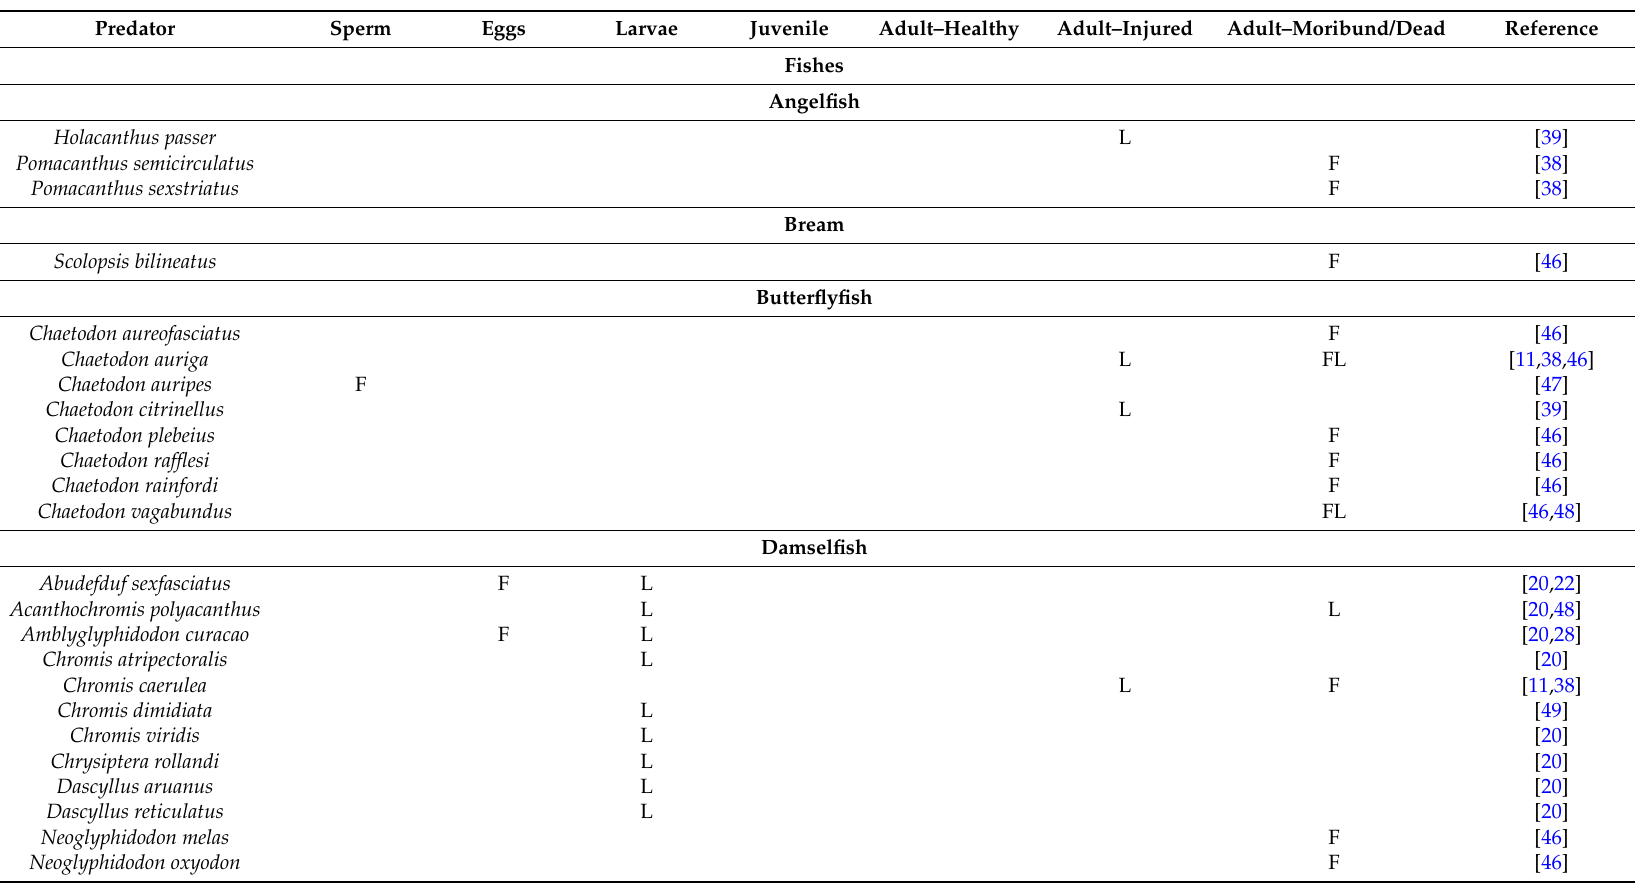
Table 1. Species that feed on different life stages and states of health of Acanthaster spp. “F” denotes that the particular predator has been directly observed feeding on a particular life stage in the field, which also includes where starfish were made unnaturally available; “L” denotes where feeding is inferred based on studies in a laboratory/aquarium; “G” denotes that Acanthaster remains have been recovered from the stomach of the predator; I = not directly